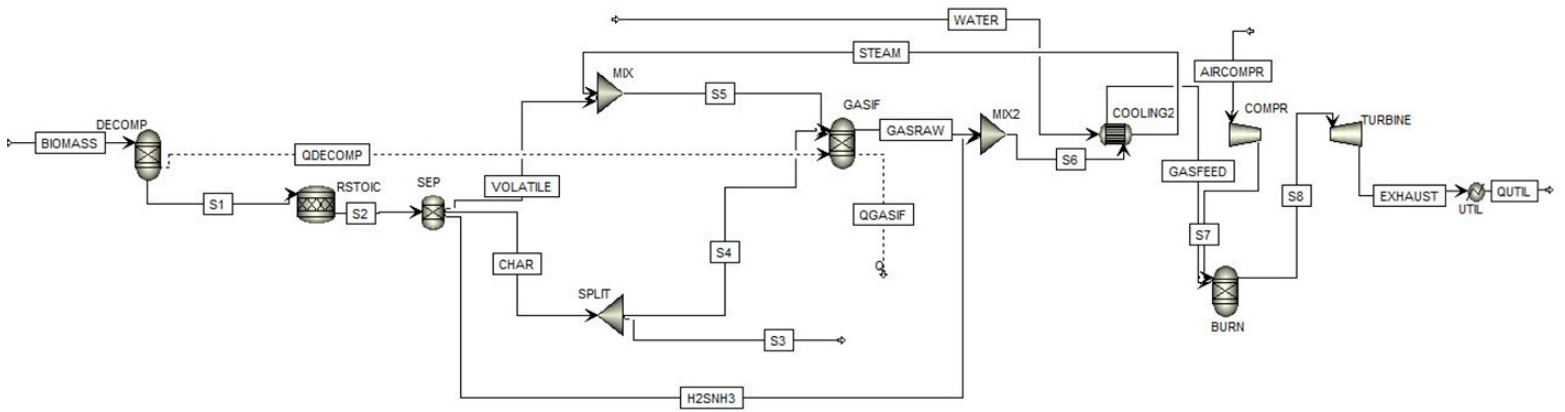
Figure 2. Flowchart of the plant evaluated in this study (the hatched streams are the heat streams, representing thermal recoveries; the continuous streams are the material streams), considering air as the gasifying agent.